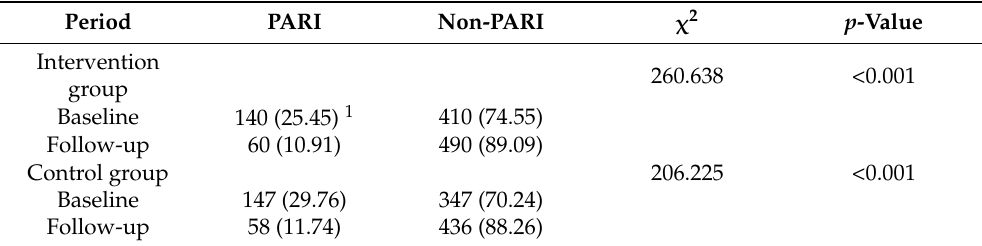
Table 3. Comparison of PARIs prevalence before and after intervention in both intervention and control